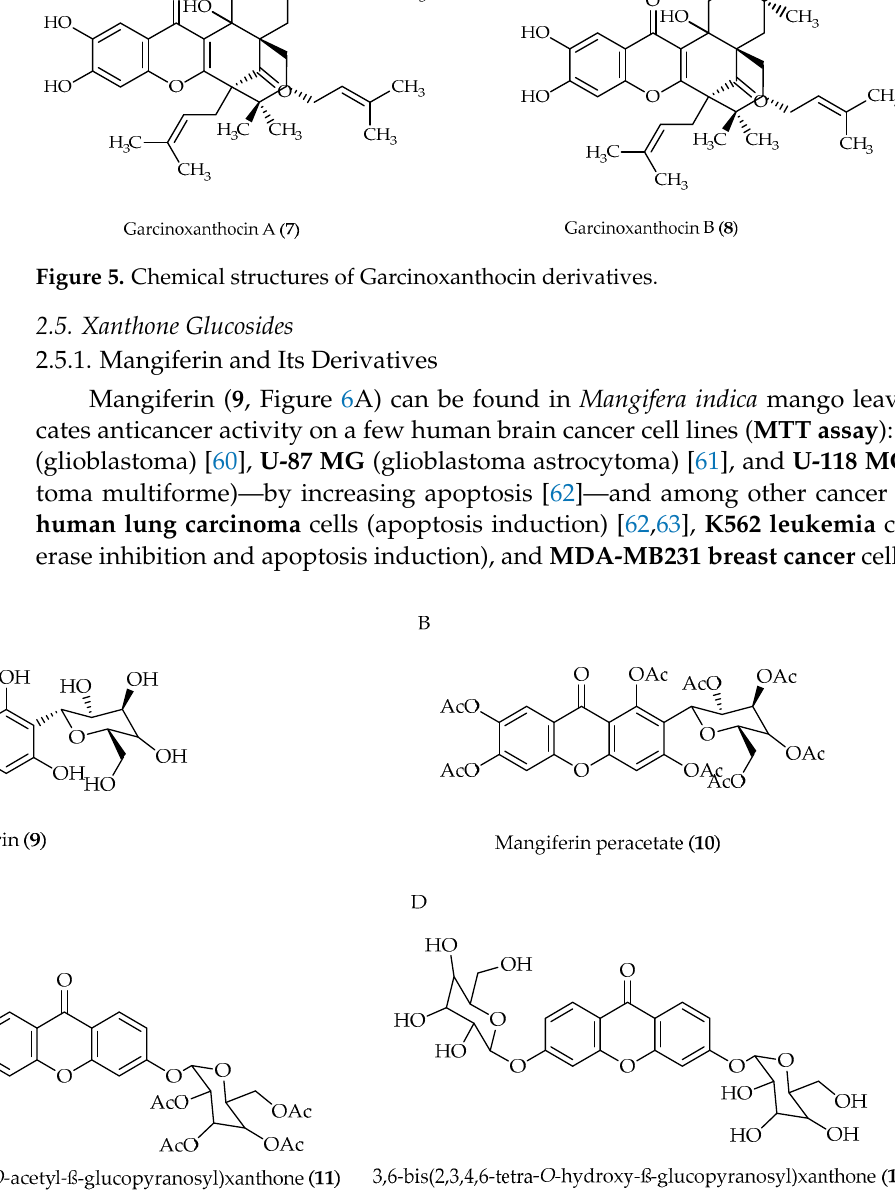
Figure 6. Chemical structures of Xanthone glucosides.